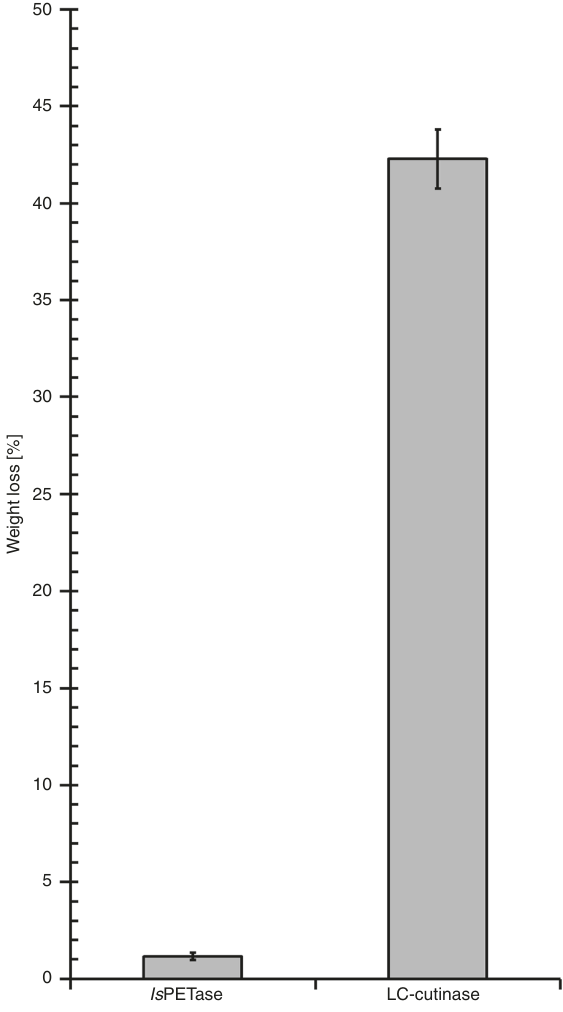
Fig. 2 Weight loss of an amorphous PET fi lm (~45 mg) as a result of enzymatic hydrolysis. Incubation with Is PETase and LC-cutinase was carried out under agitation for 24 h at 30 °C and 70 °C, respectively, i.e., at their optimal reaction conditions for PET degradation. Error bars indicate the standard deviation of triplet